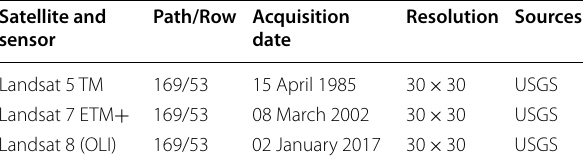
Table 1 List of time series Landsat data used for the study Satellite and